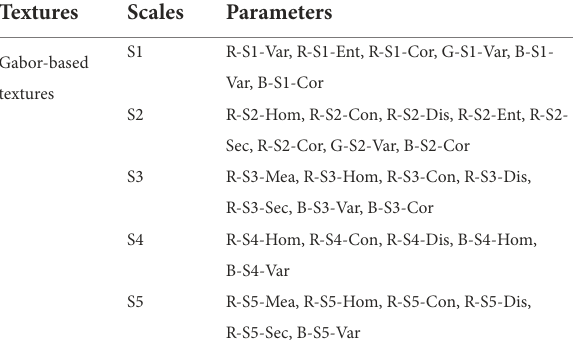
TABLE 2 Selected Gabor-based textures to estimate potato AGB.